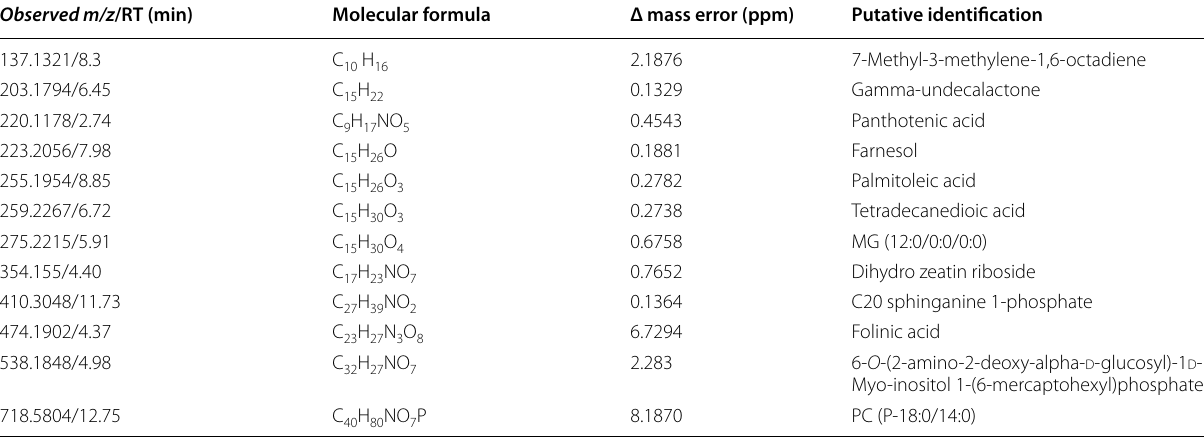
Detected in culture/ +